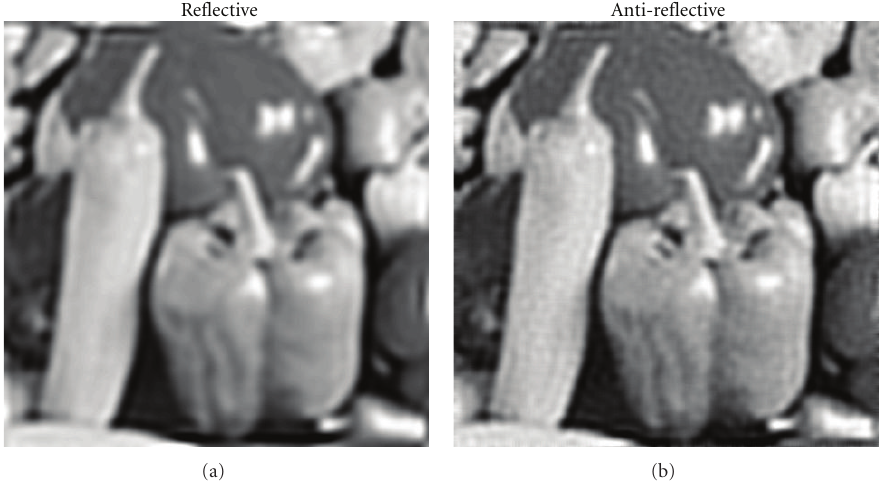
Figure 2: Restored images for the test problem in Figure 1.